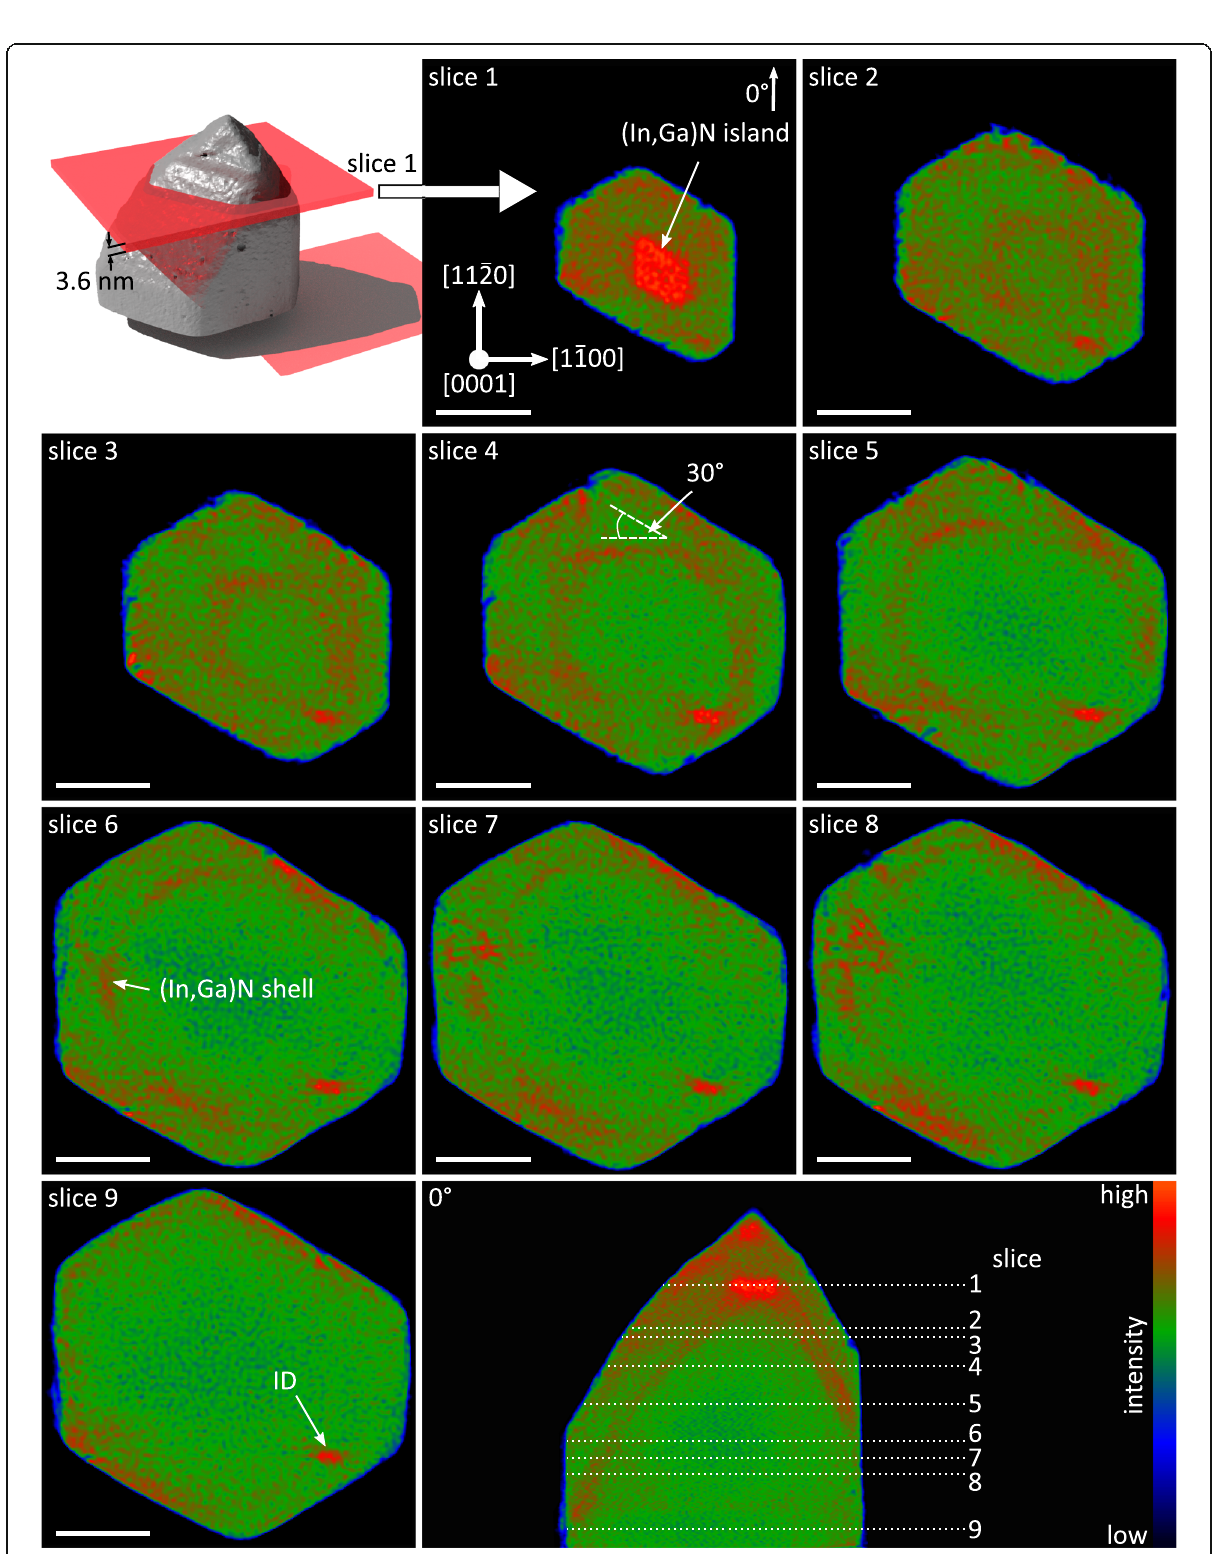
Fig. 5 Plan-view slices through the tomogram. A 3D rendered representation of the NW and a slice (upper left corner) specify the spatial position of slice 1. All slices are perpendicular to the [0001] direction, and the different slice positions are labeled in the cross-sectional slice (bottom right). The slices have a width of 3.6 nm. The length of the white scale bar corresponds to 50